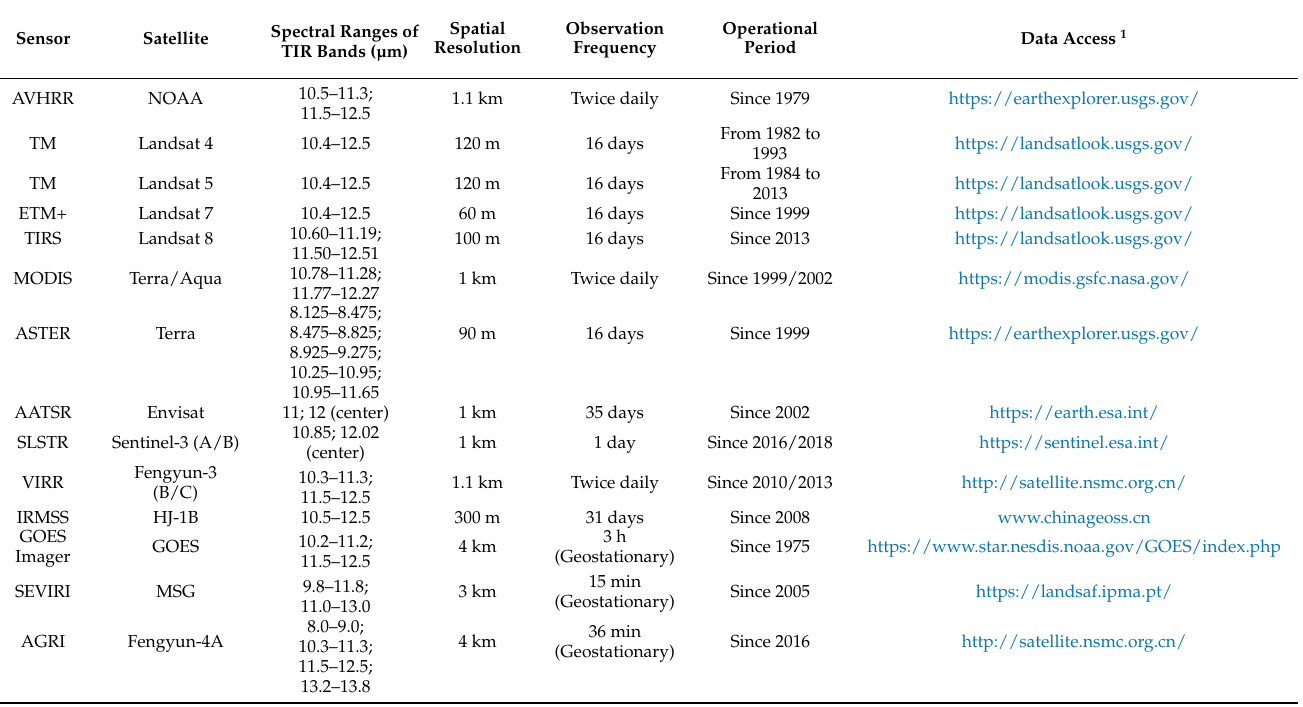
Table 1. Commonly used sensors in land surface temperature (LST)